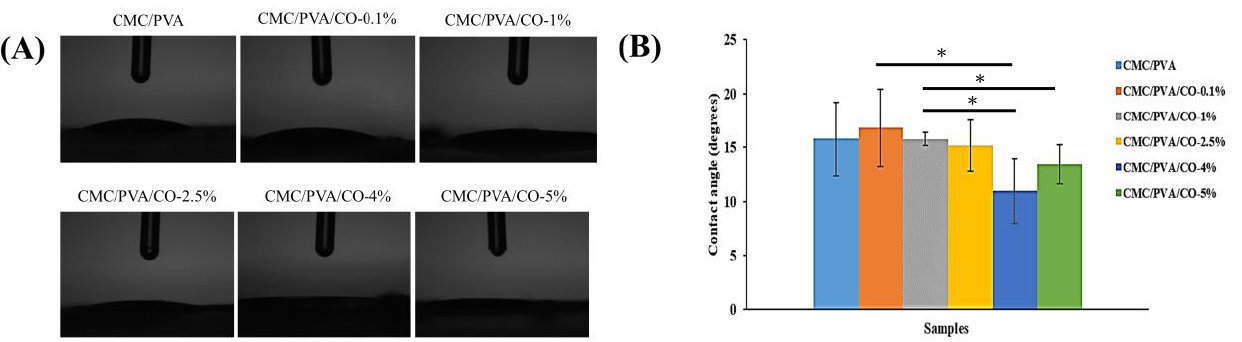
Figure 5. Contact angle analysis of the CMC/PVA/CO composite films with different CO concentra- tions (0.0%, 0.1%, 1%, 2.5%, 4%, and 5%): ( A ) digital images of the contact angles of water droplets on composite films, ( B ) average water contact angles of the composite films. Results are expressed as mean ± standard deviation and statistical significance is represented as (*) p < 0.05.